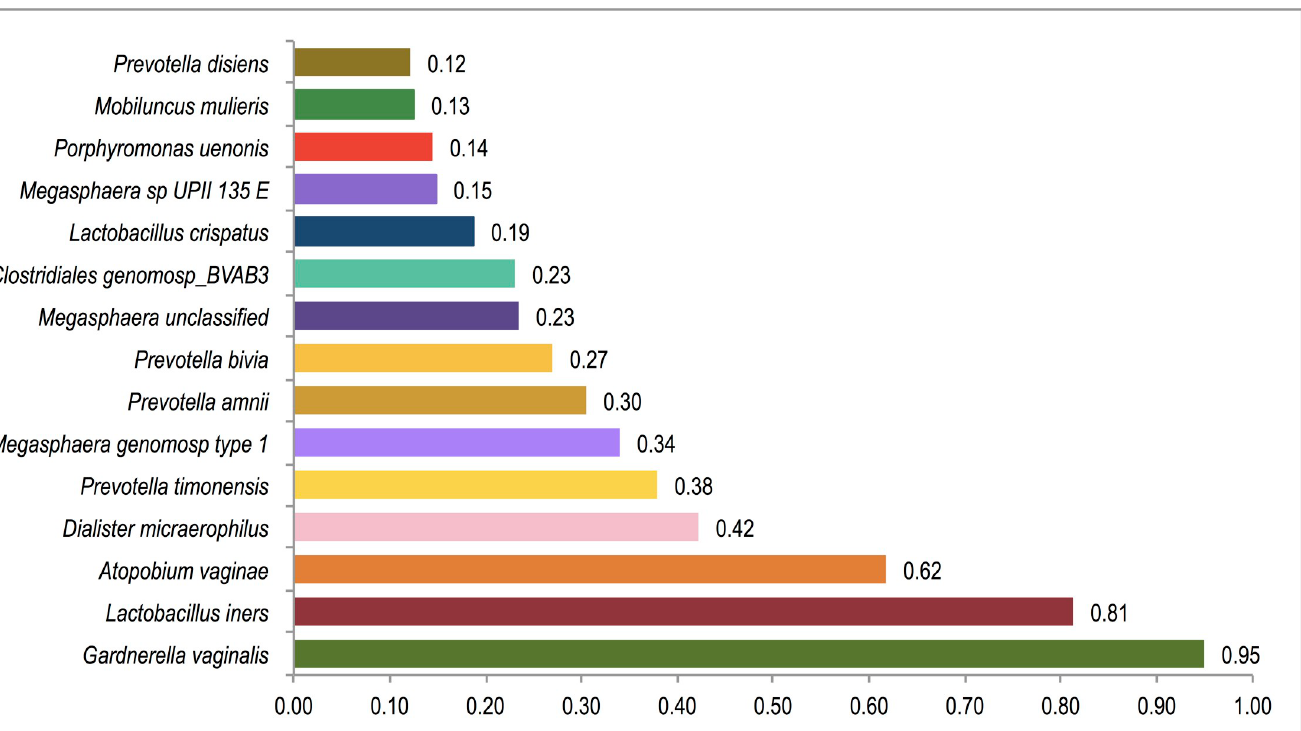
Fig 1. Prevalence of bacterial taxa in pregnant ZAPPS cohort, n = 256. Overall prevalence of each of the 15 most common bacterial taxa across all participants, with Gardnerella vaginalis , Lactobacillus iners , and Atopobium vaginae , each isolated in over half of all